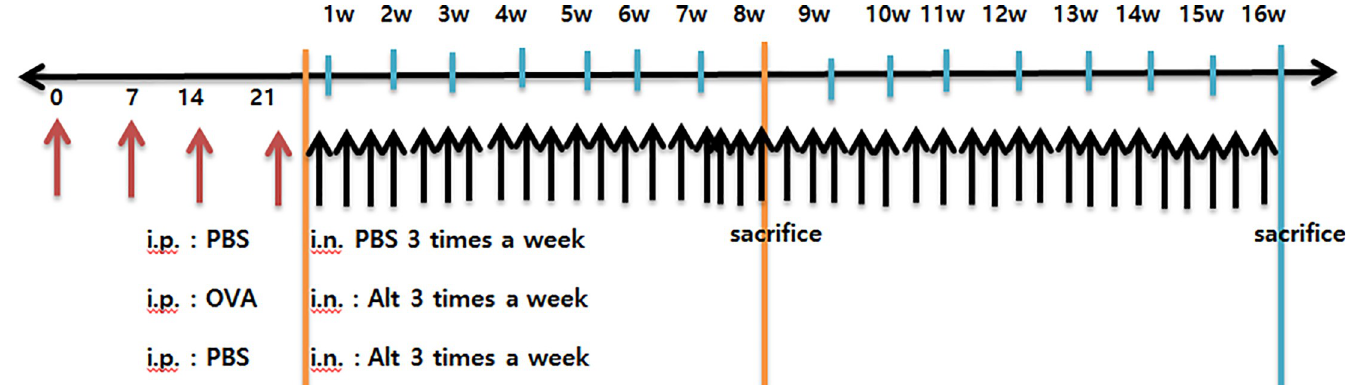
Fig 1. Schematic diagram of Alternaria induced chronic rhinosinusitis mouse model. Intraperitoneal injection of ovalbumin (OVA) then intranasal instillation of Alternaria for 8 or 16 weeks was designed as an allergic CRS model. Intraperitoneal injections of phosphate buffered saline (PBS) then intranasal instillation of Alternaria for 8 or 16 weeks were designed as non-allergic CRS model. Intraperitoneal injection of PBS then intranasal instillation of PBS for 8 or 16 weeks was designed as negative control